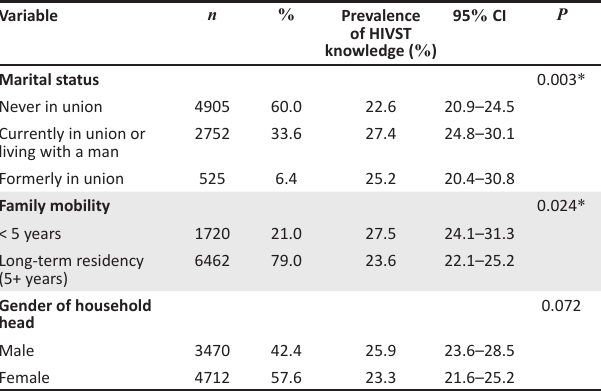
TABLE 2: Distribution of HIV self-testing knowledge amongst South African women ( N = 8182). Variable